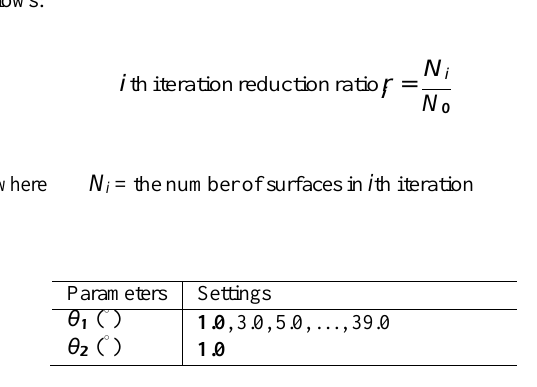
shows changes in the average size of all surfaces.